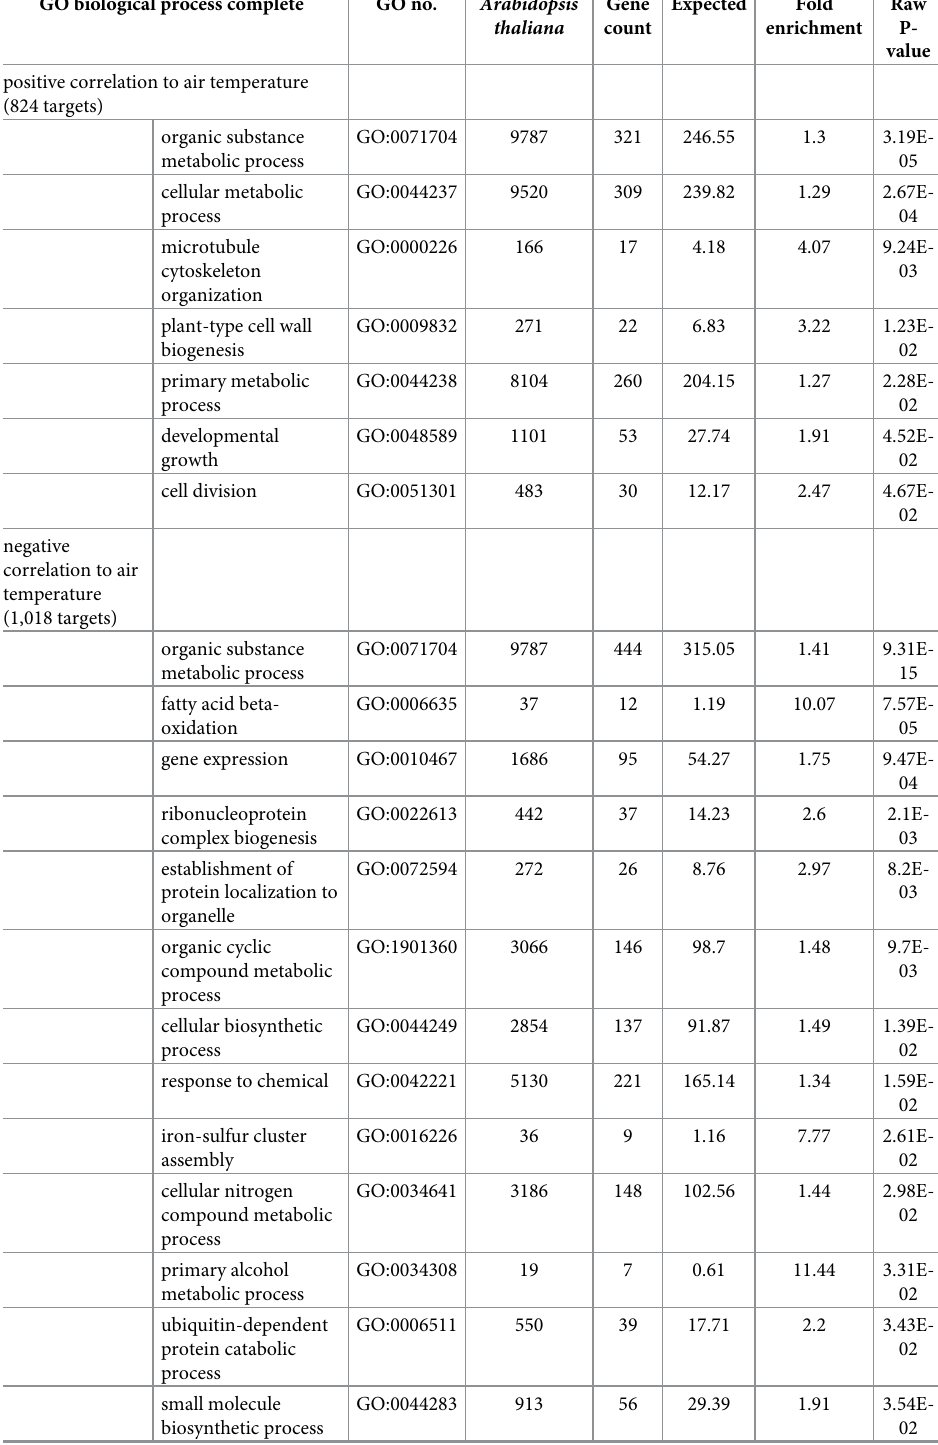
Table 5. Functional categories overrepresented among targets correlated with the parameters of air